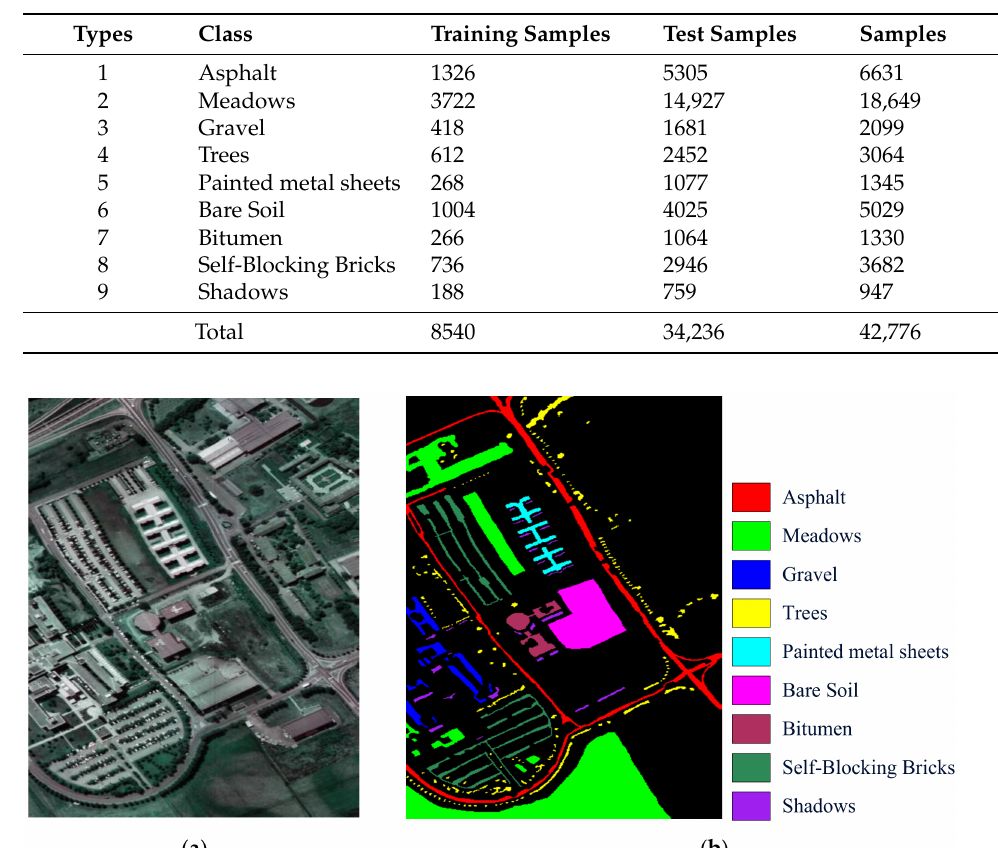
Table 2. The number of samples in Pavia University.